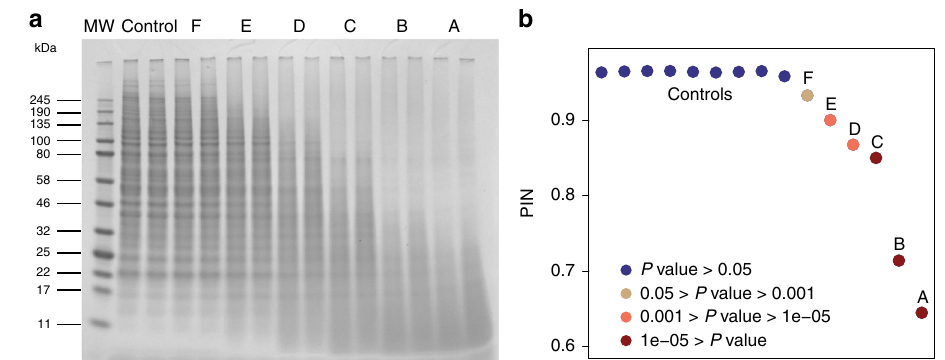
Fig. 2 The benchmarking study to validate the PIN algorithm. a The uncropped SDS-PAGE gel showing the effect of sample treatment with different amounts of protease on the proteome level. Lanes: 1, MW Marker; 2, Controls (without protease treatment); 3 – 8, Samples F-A as de fi ned in Table 1. b Scatter plot of sorted PIN values of the samples of the benchmarking study. The samples with P -values above 0.05 are marked in blue; those with P -values between 0.001 and 0.05 are in coffee; those with P -values between 1e − 5 and 0.001 are in orange; those with P -values below 1e − 5 are in dark red